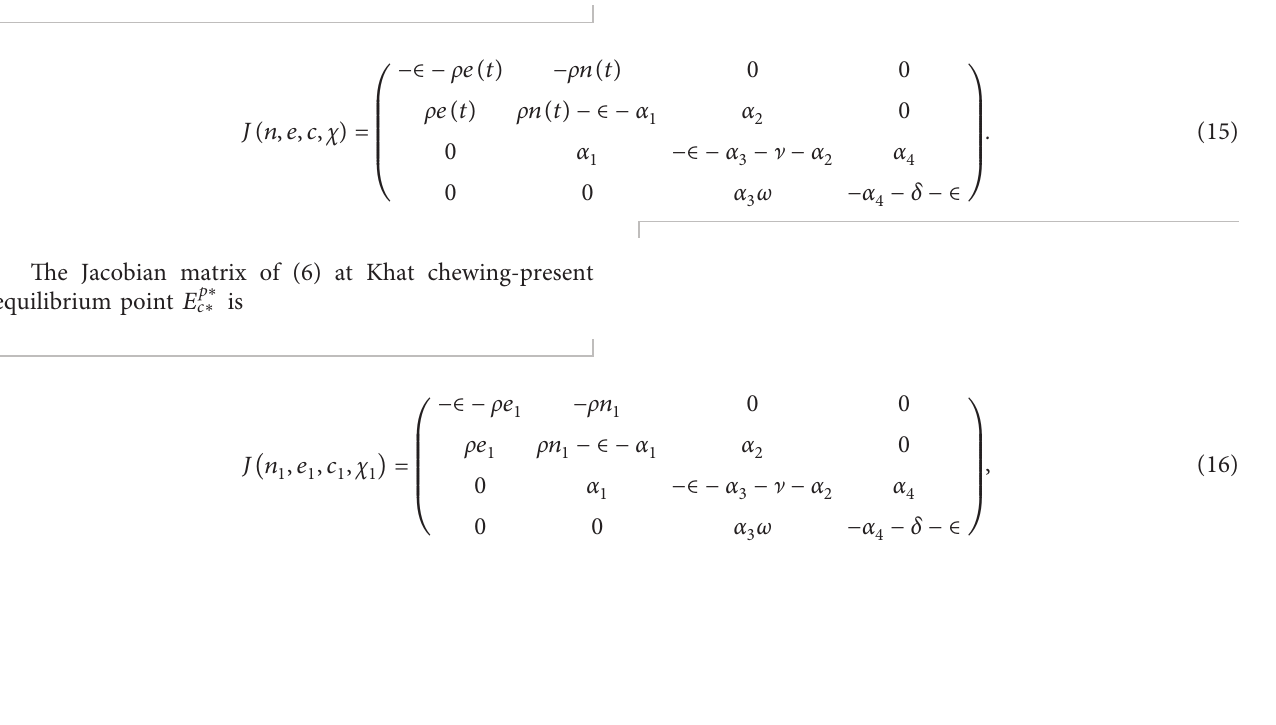
< 1 (the Jacobian matrix has a negative 0 < 1), and E ∗ is stable. Hence, E c is stable. c ∗ 0 ∗ , ( ℵ + ℵ ) or ℵ ℵ / ℵ are positive, 1 1 2 3 3 3 > 1, and E ∗ is unstable. Hence, E c is c ∗ 0 ∗